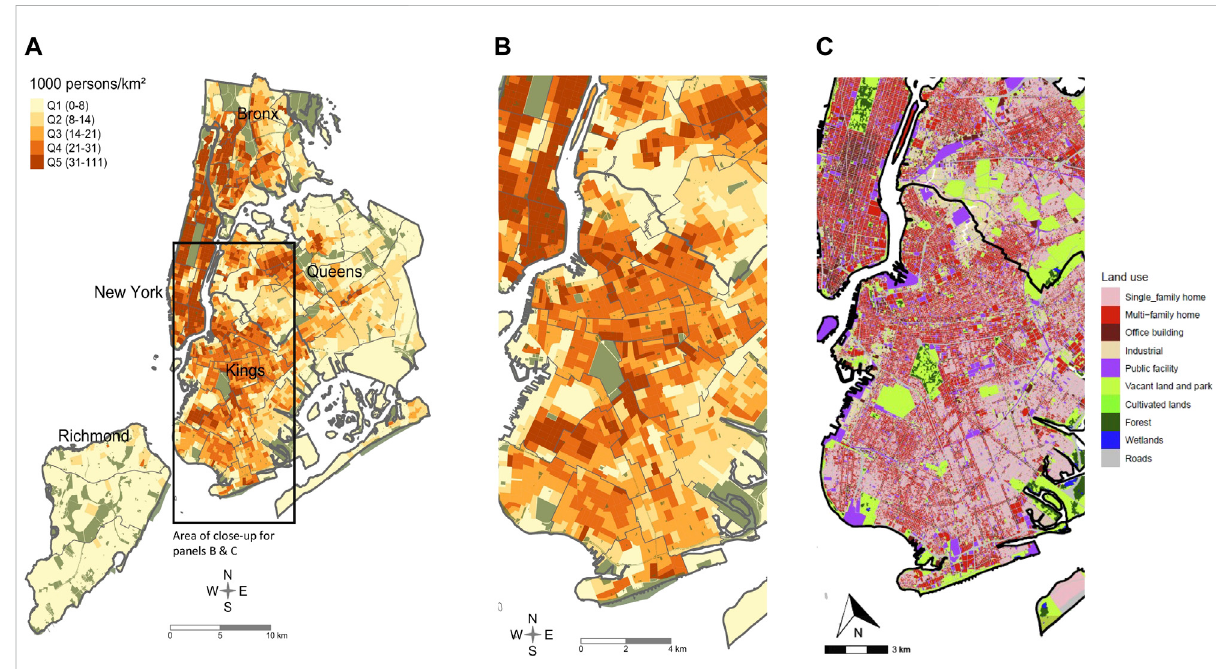
FIGURE 1 Population Density, 2000, with Public Use Microdata Area (PUMA) and county borders ( (A) , entire city; (B) , close-up), and Land Use ( (C) , close- up), 2016, New York